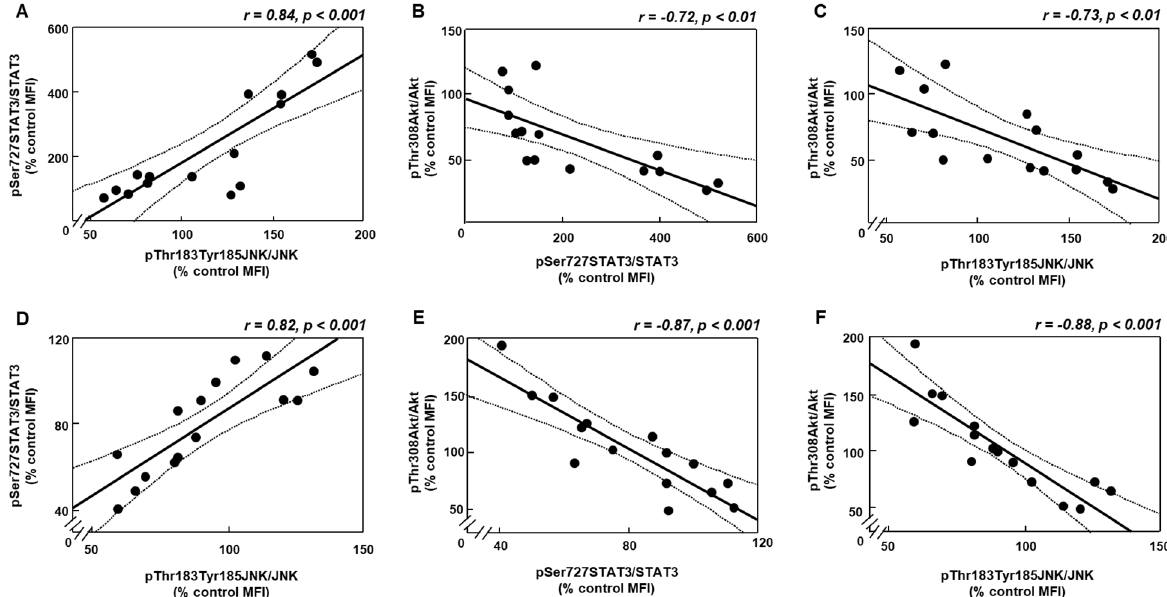
Figure 5. Correlations between leptin-, inflammatory- and insulin-related targets. ( A ) Linear correlation between relative protein levels of signal transducer and activator of transcription 3 (STAT3) phosphorylated (p) at Ser727 (pSer727STAT3) and c-Jun N-terminal kinase (JNK) phosphorylated at Thr183 and Tyr185 (pThr183Tyr185JNK) in the inguinal fat. ( B ) Linear correlation between relative protein levels of Akt phosphorylated at Thr308 (pThr308Akt) and pSer727STAT3 in the inguinal fat. ( C ) Linear correlation between relative protein levels of pThr308Akt and pThr183Tyr185JNK in the ingui- nal fat. ( D ) Linear correlation between relative protein levels of pSer727STAT3 and pThr183Tyr185JNK in the liver. ( E ) Linear correlation between relative protein levels of pThr308Akt and pSer727STAT3 in the liver. ( F ) Linear correlation between relative protein levels of pThr308Akt and pThr183Tyr185JNK in the liver. MFI, median fluorescent intensity. The 95% confidence interval is indicated by hatched curves. Correlation coefficients (r) and p values are represented for each analysis.